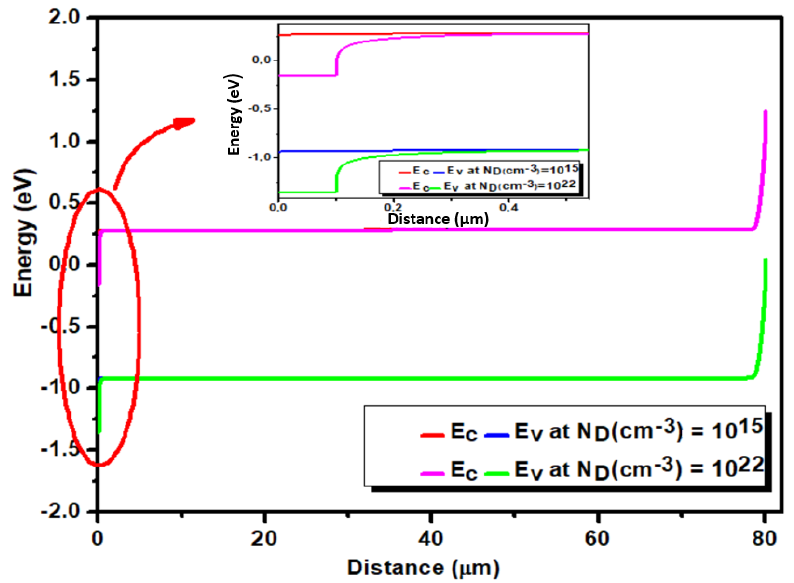
Figure 7. Effect of the doping concentration on the energy band diagram of the bottom sub-cell.